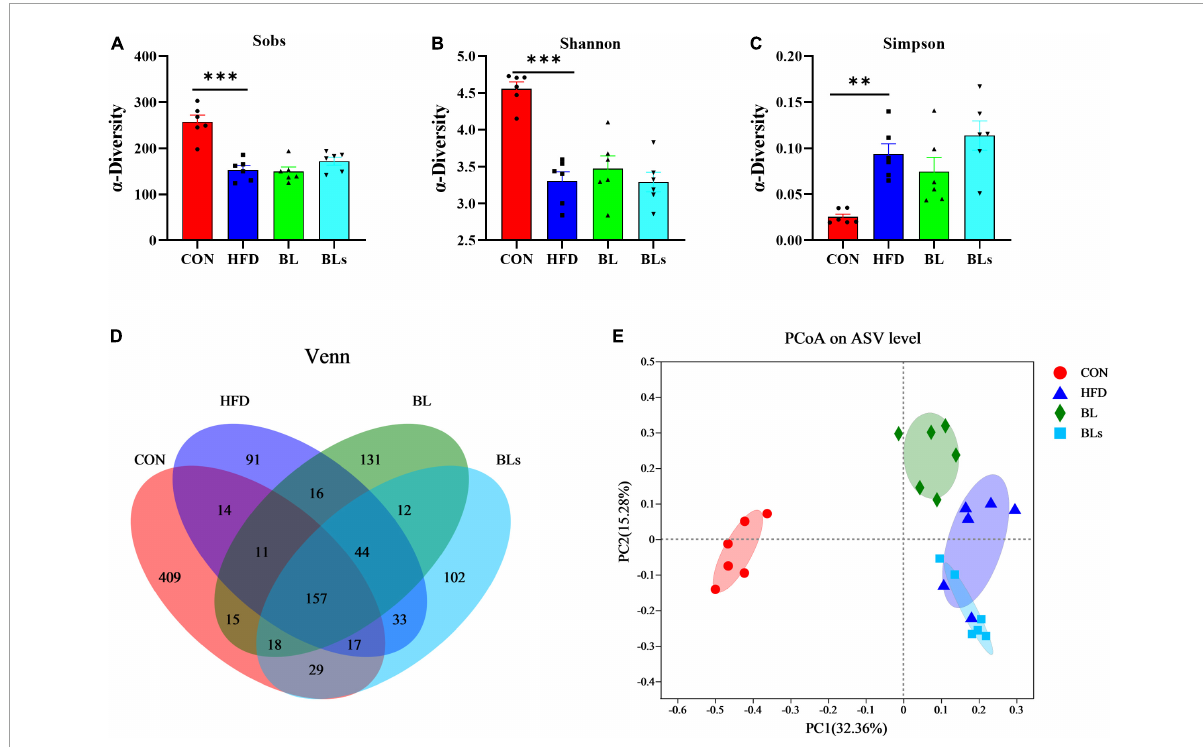
FIGURE6 Brevibacillus laterosporus BL1 treatment altered gut microbiota diversity and composition in HFD-fed mice. (A–C) Sobs, Shannon, and Simpson indices in α -diversity analysis, (D) Venn diagrams showing the observed overlap of ASVs, (E) PCoA plot analysis from each sample. Data are presented as mean ± SEM ( n = 6) and analyzed using one-way ANOVA. Significant differences between HFD and CON are indicated by ∗∗ p < 0.01 and ∗∗∗ p <